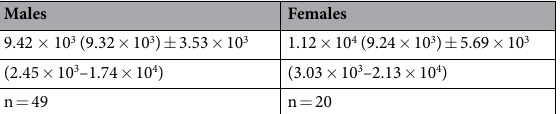
Table 3. Total mercury concentrations (ng.g − 1 dry weight, dw) in the skin biopsies of the bottlenose dolphins from Normanno-Breton Gulf. The data are presented as the mean (median) ± the standard deviation (min–max values) and the number of individuals analysed